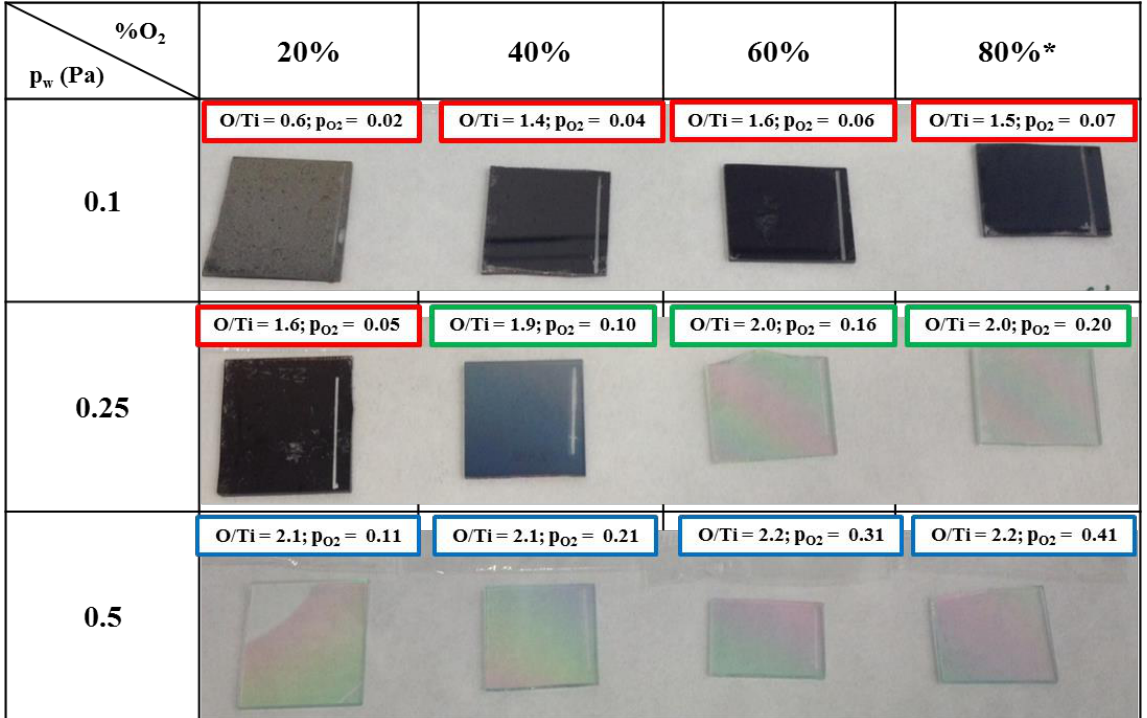
Figure 2. Summary table of deposited samples with varying % of Ar/O 2 gas flow, and P w including: picture of each sample deposited on glass, p O2 during deposition and elemental at.% (O/Ti ratio) obtained by RBS. The code color indicates the samples belonging to group 1 (red), 2 (green), and 3 (blue). * For the lower working pressure (0.1 Pa), it was not possible to perform the deposition process with more than 70% of oxygen gas flow.